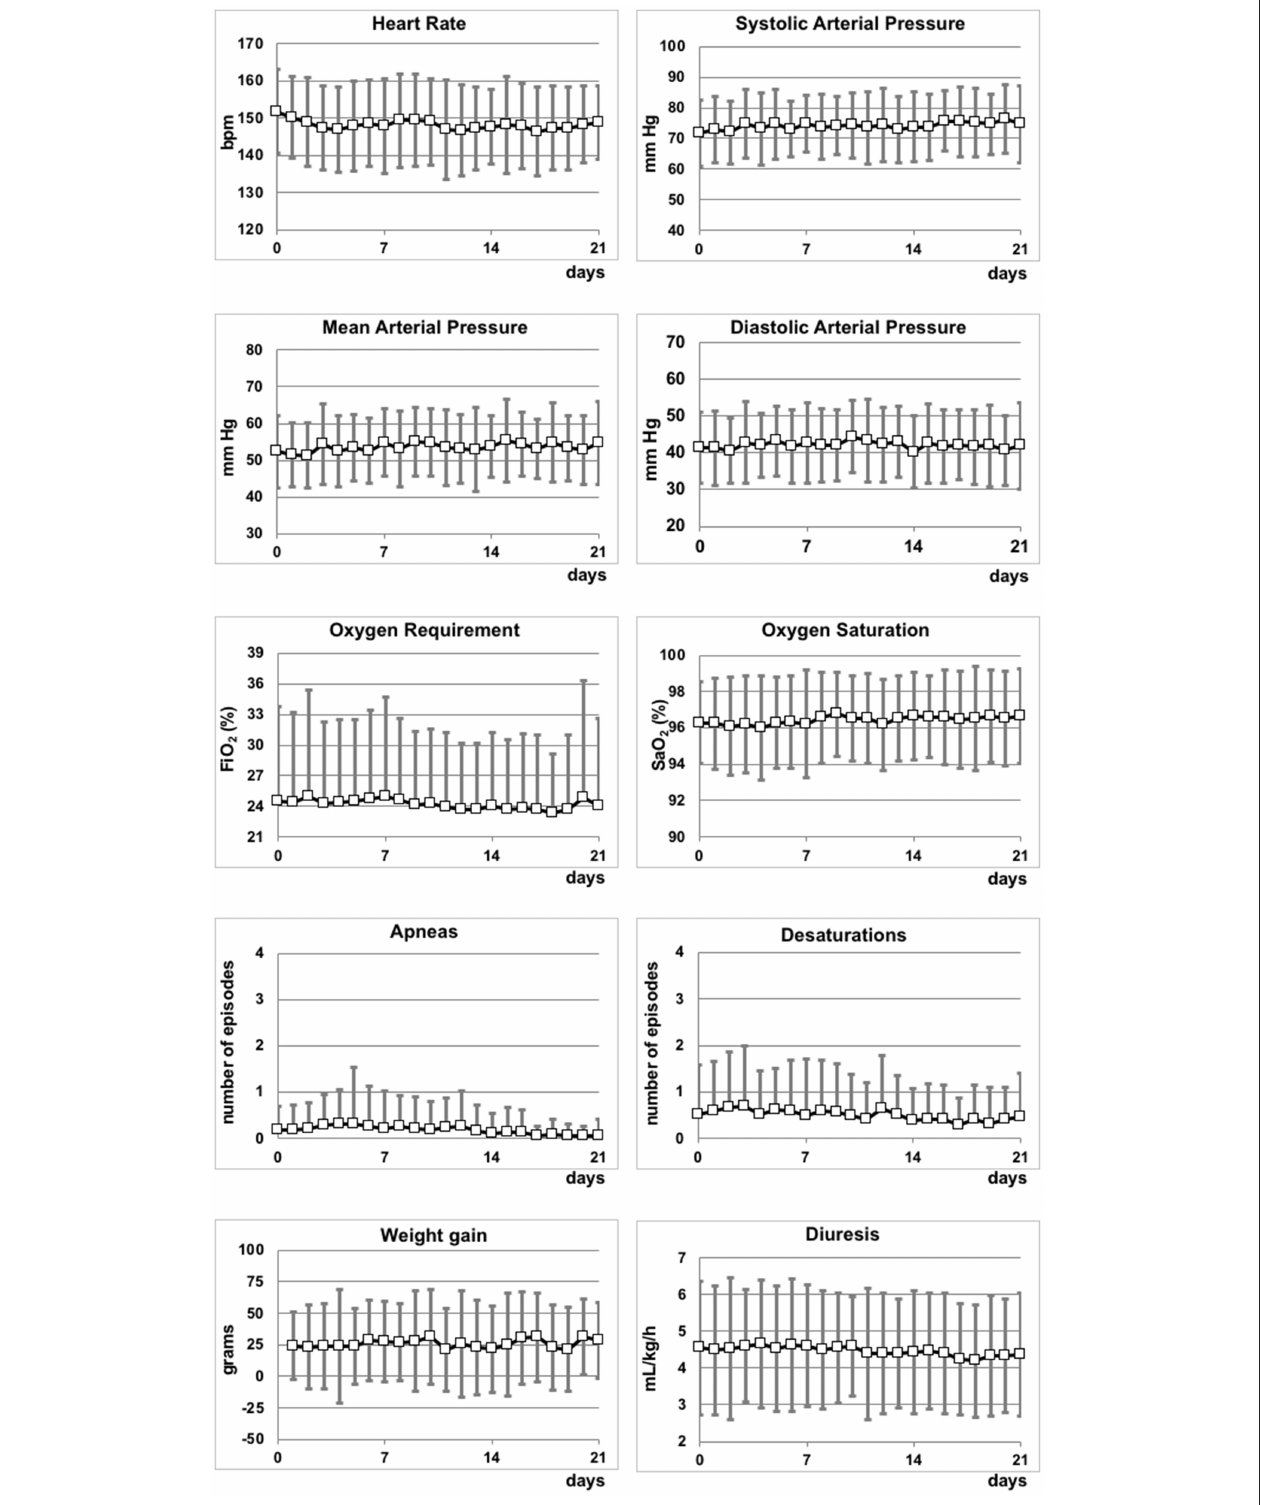
FIGURE 2 | Hemodynamic and respiratory parameters, weight gain and diuresis during the first 21 days of the study.